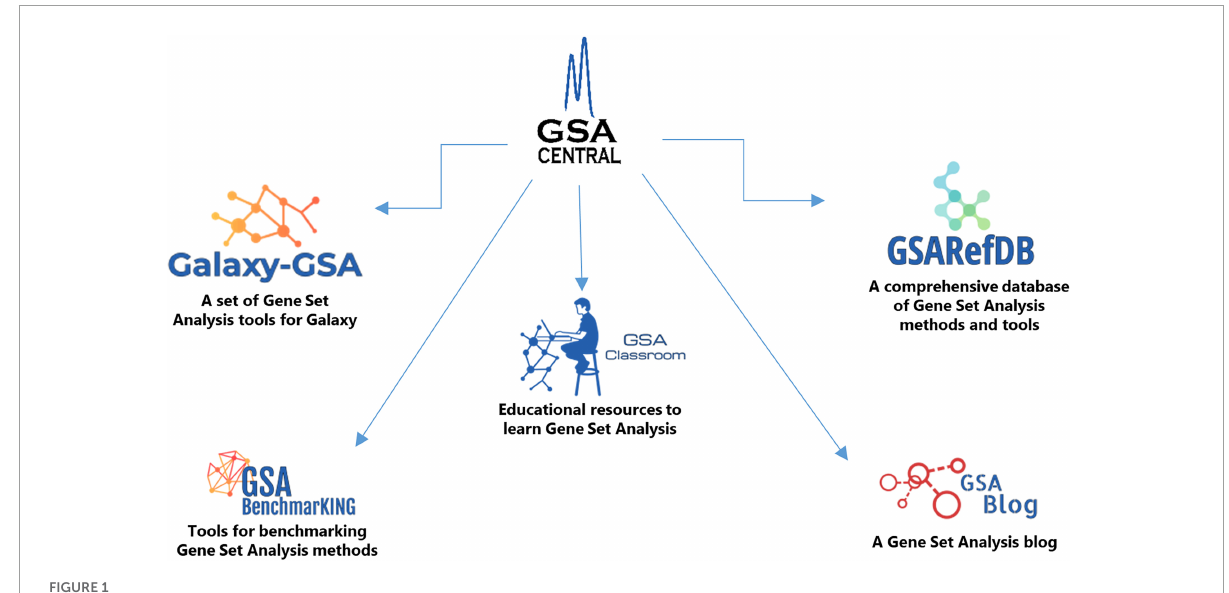
FIGURE1 GSA Central